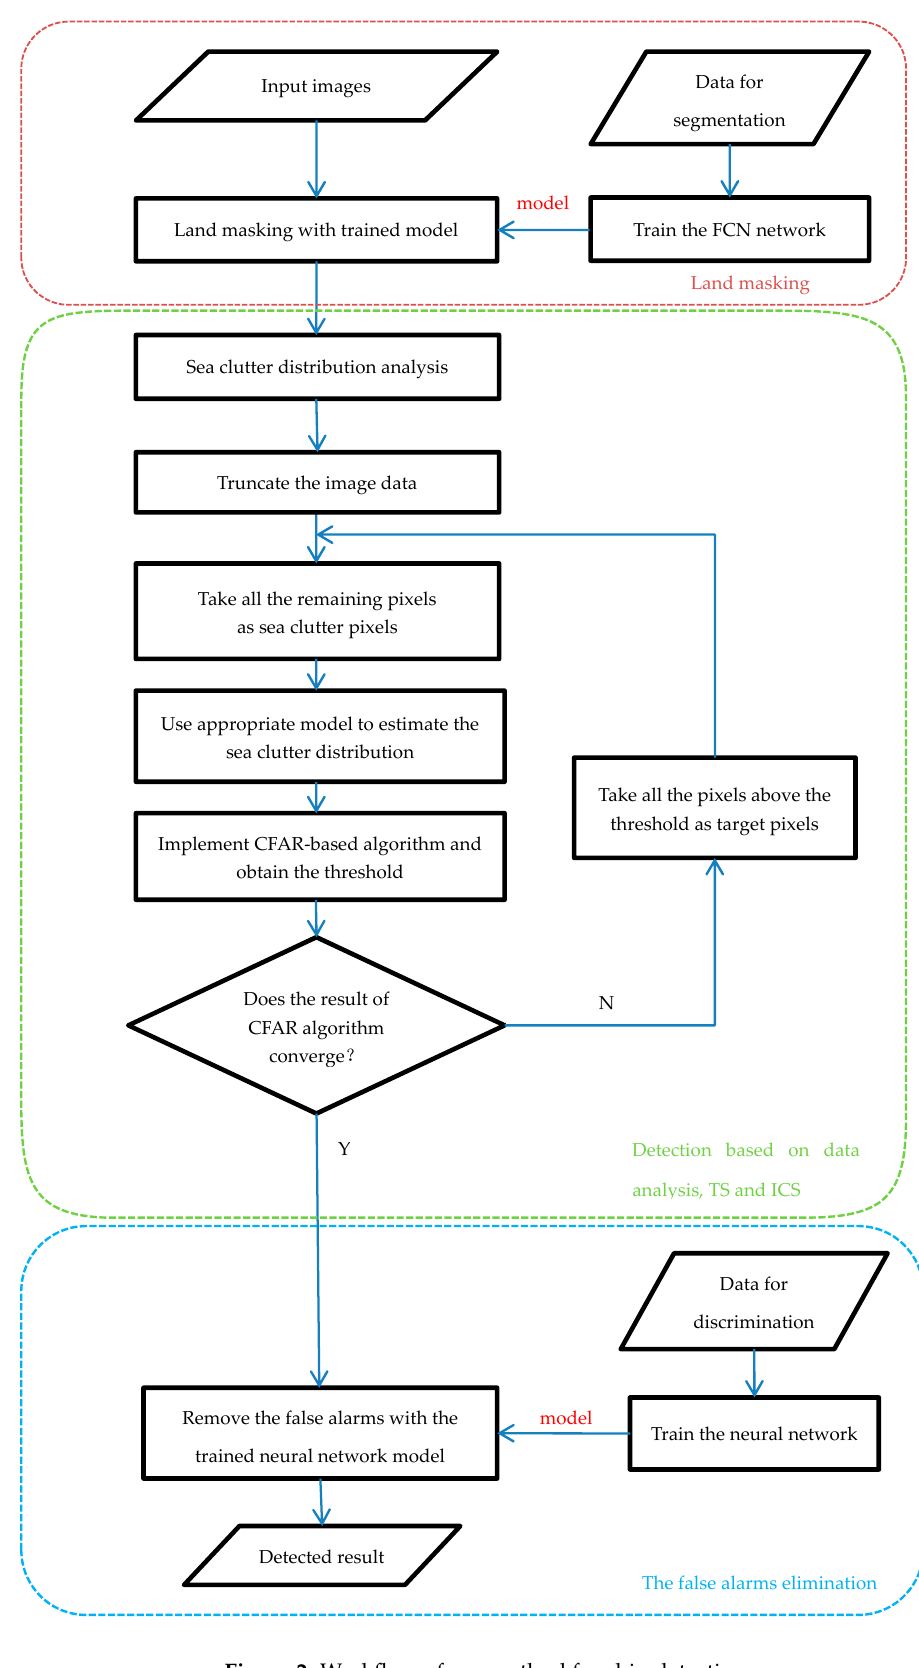
Figure 2. Workflow of our method for ship detection.